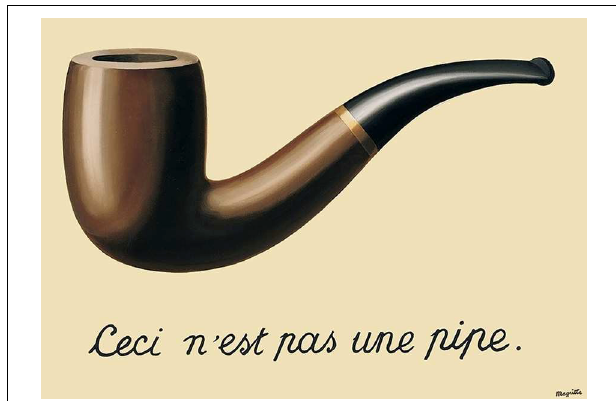
FIGURE 10 | Rachel Whiteread, Judenplatz Holocaust Memorial, 2000, Concrete, Judenplatz, Vienna. Image source: Wikimedia Creative Commons. http://commons.wikimedia.org/wiki/File:Holocaust_Mahnmal_ Vienna_Sept_2006_001.jpg. By